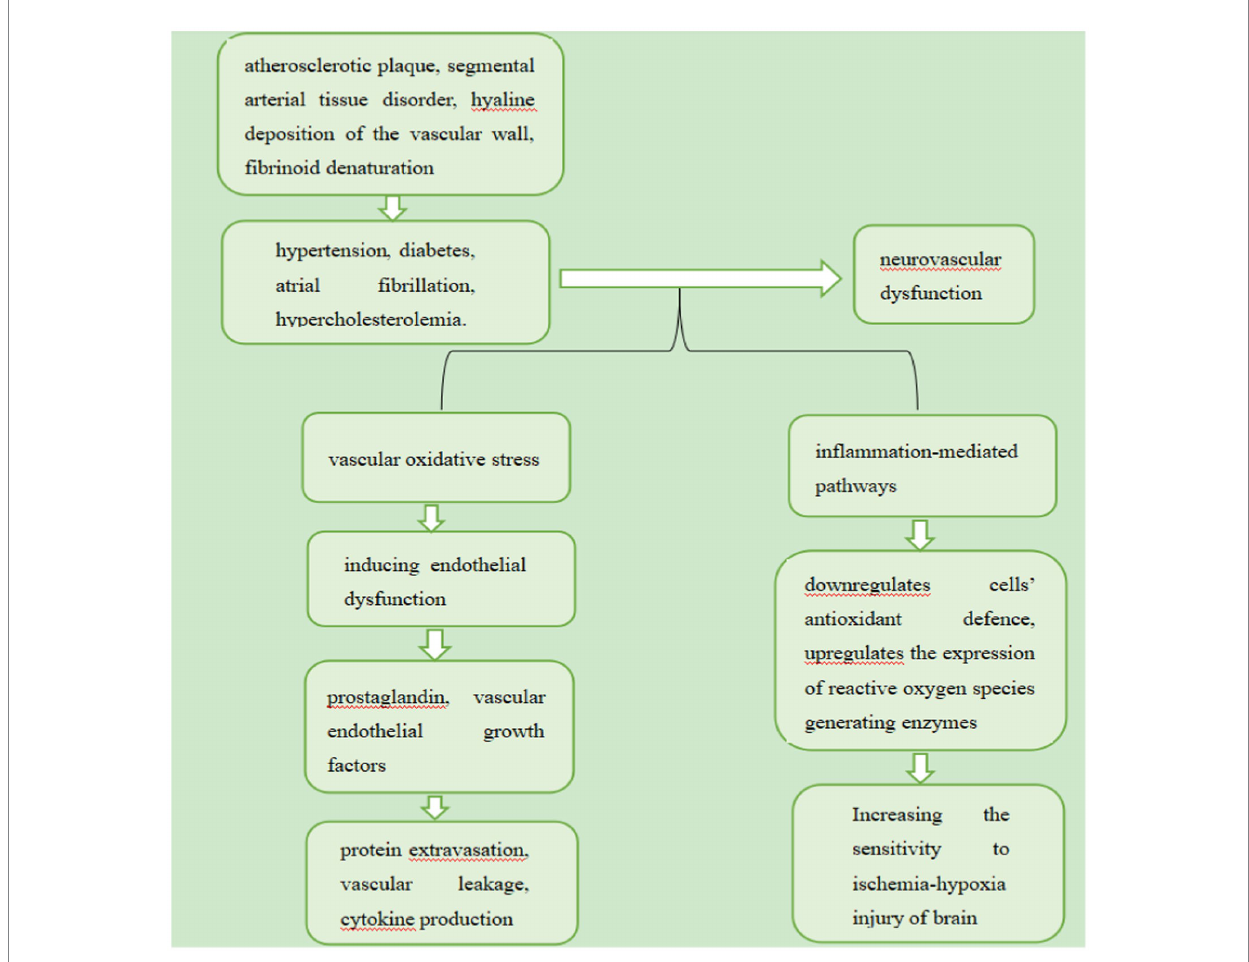
FIGURE 1 Certain vascular risk factors underlie the pathological mechanisms of